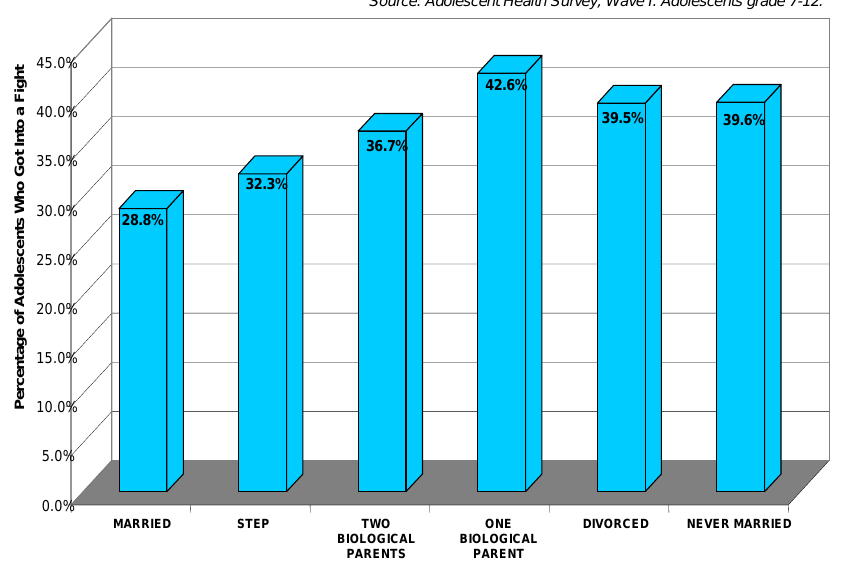
Source: Adolescent Health Survey, Wave I. Adolescents grade